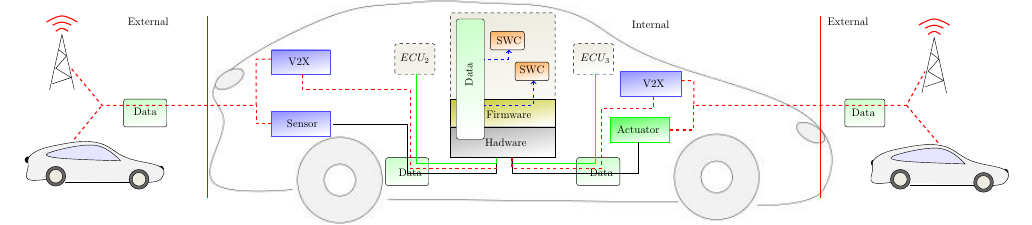
Figure 3. The different assets of the automotive